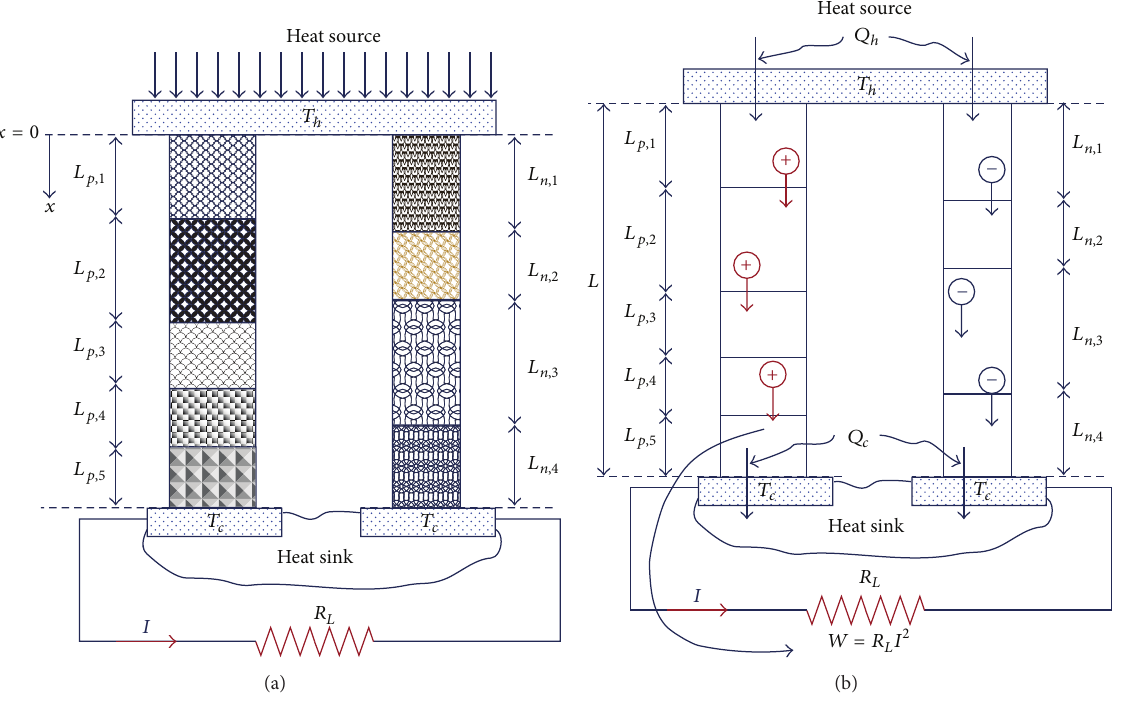
Figure 1: Schematic of a segmented thermoelectric